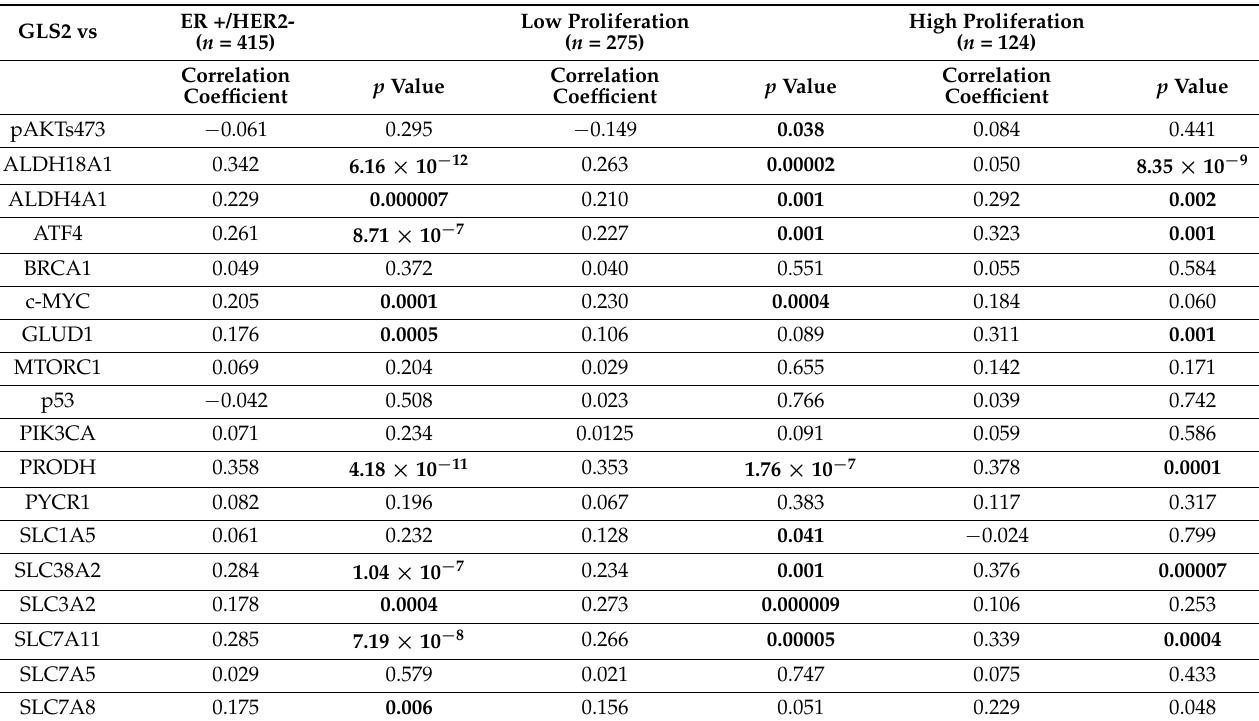
Table 4. Correlation of GLS2 protein expression with glutamine-metabolism-related proteins in invasive luminal breast cancer. GLS2